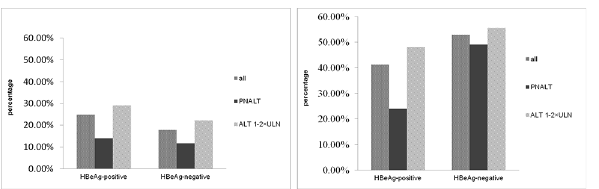
Fig 1. Distribution of significant necroinflammation and fibrosis among 300 chronic hepatitis B patients. (A) Significant necroinflammation ( (cid:3) G2) was found in 24.9%, 14.0% and 29.1% in all patients, PNALT (ALT (cid:1) 40 U/ml) and ALT 1 – 2×ULN subgroups in HBeAg-positive patients, and 17.9%, 11.8% and 22.2% in all patients, PNALT and ALT 1 – 2×ULN subgroups in HBeAg-negative patients, respectively. (B) Significant fibrosis ( (cid:3) S2) was found in 41.2%, 24.0% and 48.0% in all, PNALT and ALT 1 – 2×ULN subgroups in HBeAg-positive patients, and 52.9%, 49.0% and 55.6% in all, PNALT and ALT 1 – 2×ULN subgroups in HBeAg-negative patients, respectively. Frequencies of significant necroinflammation and fibrosis in HBeAg- positive patients with ALT 1 – 2×ULN were much higher than in patients with normal ALT (P < 0.05).